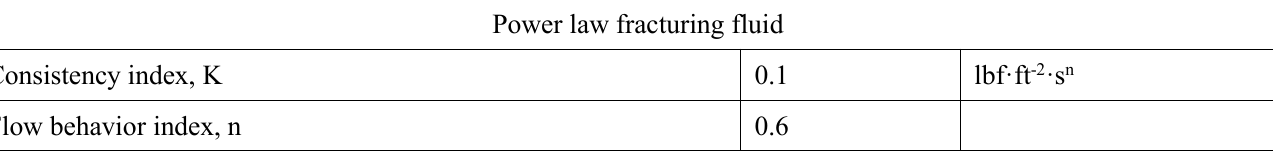
Table 3—Fracturing fluid data.